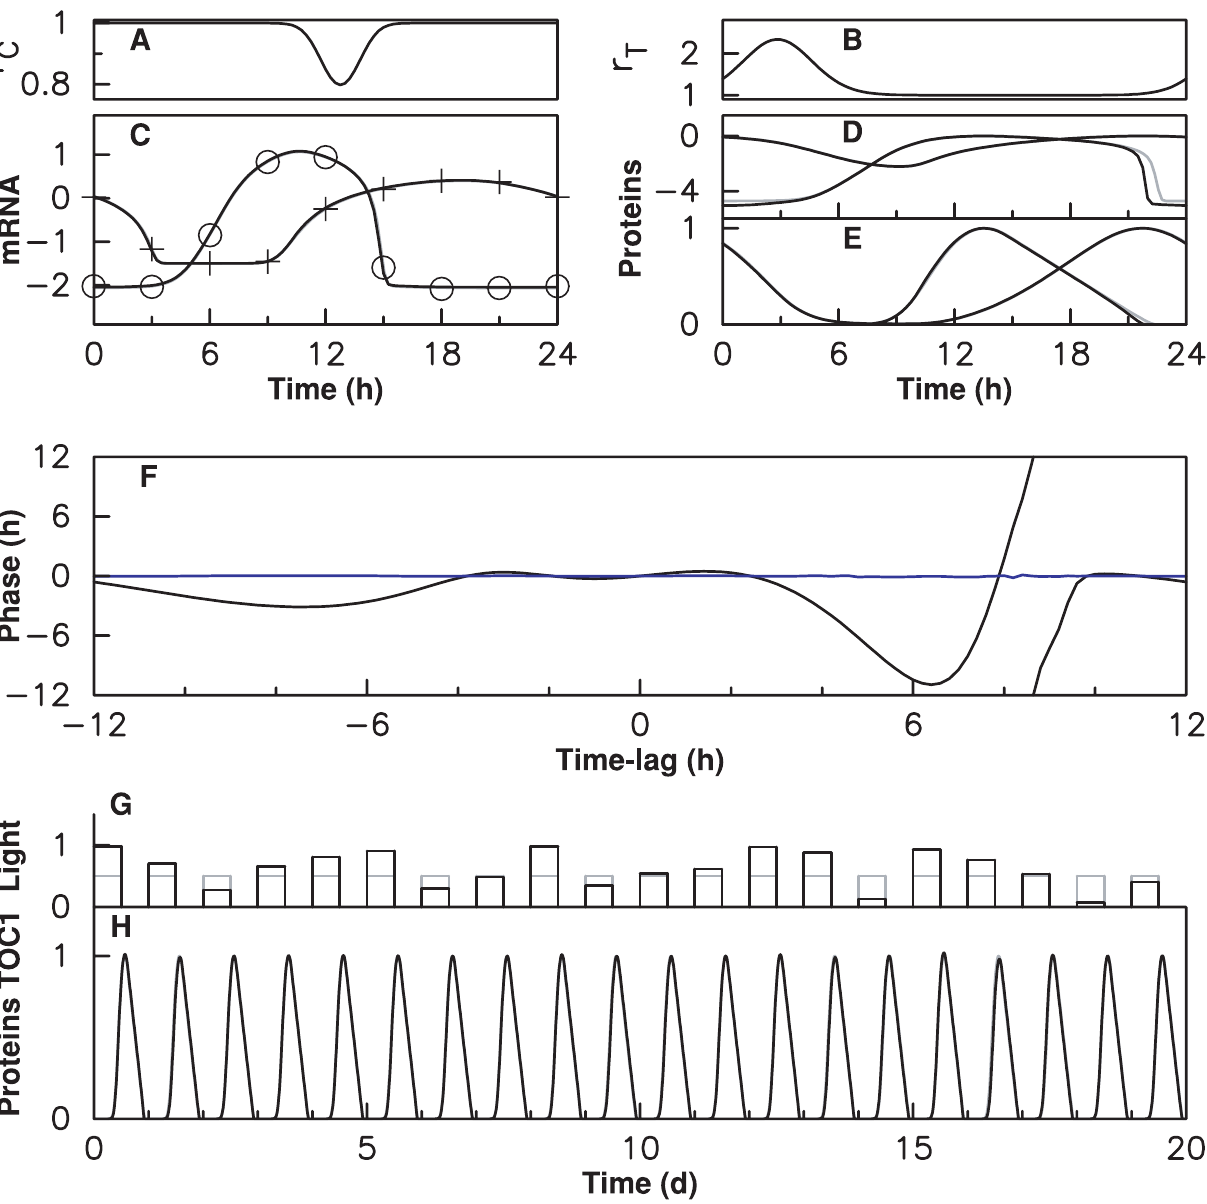
Figure 10. Dynamical behavior of a clock model with gating by Gaussian-shaped modulation profiles. (A) Temporal profile of the CCA1 = d 0 ( k C ~ 0 : 25 , t C ~ 12 : 8 , s C ~ 0 : 17 ) (B) Temporal profile of the TOC1 protein stability modulation protein stability modulation coefficient r C ~ d P P C C = d 0 ( k T ~ 1 : 34 , t T ~ 2 : 8 and s T ~ 0 : 33 ). (C), (D) and (E) display numerical solutions of model (2) without coupling (in gray, same coefficient r T ~ d P P T T parameter values as in Fig 2(B)) and with coupling shown in (A) and (B) (in black). In (C) crosses (resp. circles) indicate the Cca1 (resp. Toc1 ) microarray data used as target. Protein profiles are shown in (D) (logarithmic scale) and (E) (linear scale). (F): Resetting of the clock after a phase-shift of the day/ night cycle. Solid curves display the residual phase shift of the clock after 1 (black) and 5 (blue) day/night cycles as a function of the initial phase-shift. (G) Fluctuating daylight intensity (H) Response of the clock model with smooth coupling profiles to these fluctuations. The protein stability coefficients k X (see Methods) depend on daylight intensity L [ ½ 0,1 (cid:2) according to k X ( L ) ~ k X ( L ~ 0 : 5) | 3 2 L { 1 .